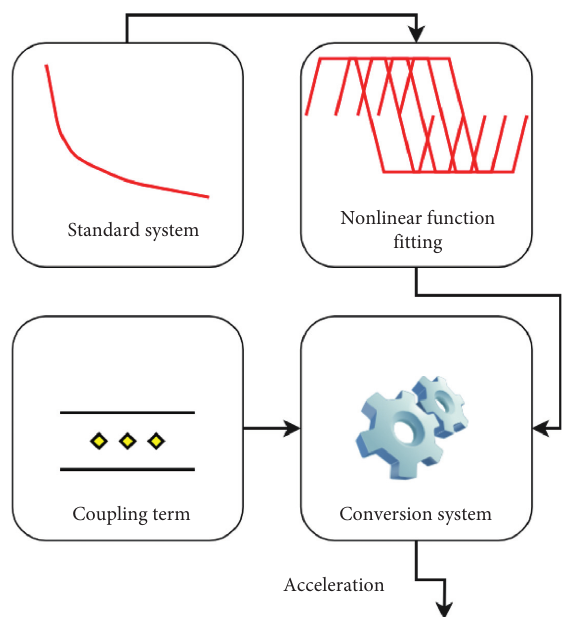
Figure 2: Block diagram of the DMP Internet of Health Things